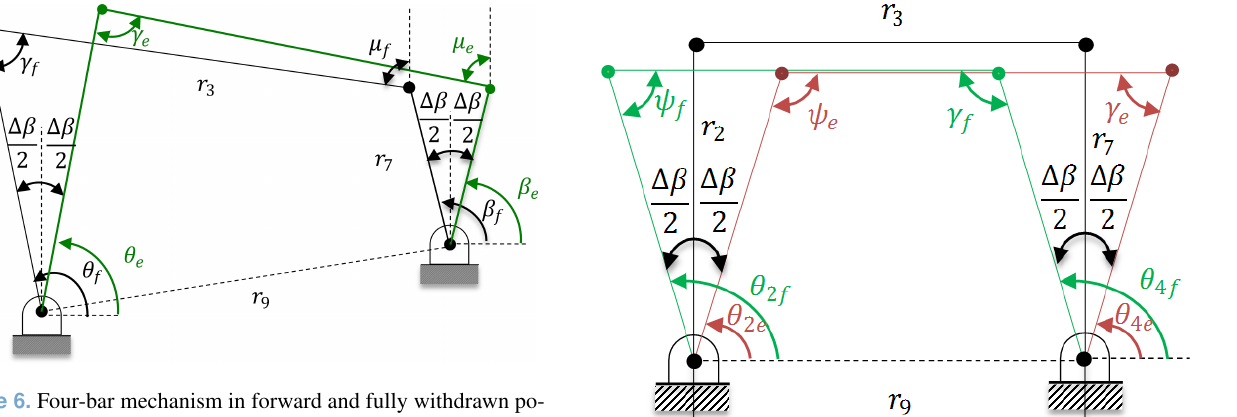
A parallelogram four bar mechanism as presented in Fig. 7 is a neat solution according to the requirements. Green, black, and red lines represent the fully withdrawn, unde- flected, and forward positions of the mechanism respectively. of links 2 and 7 is (cid:49)β , and the undeflected position is exactly treme positions are symmetric with respect to the undeflected (vertical)